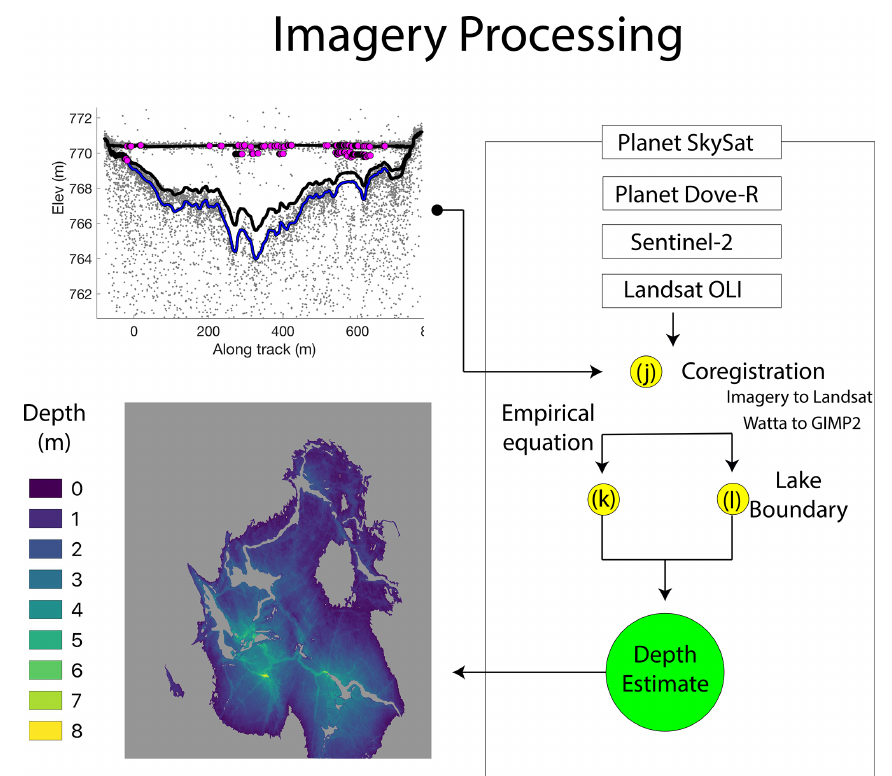
Figure 3. Diagram of imagery processing steps accepting Watta outputs as input (top left panel) and producing lake depth estimates (bottom left panel). The Watta lake depth profile shown is for Lake Ay¸se using RGT 841 on 23 May and Planet SkySat imagery on 22